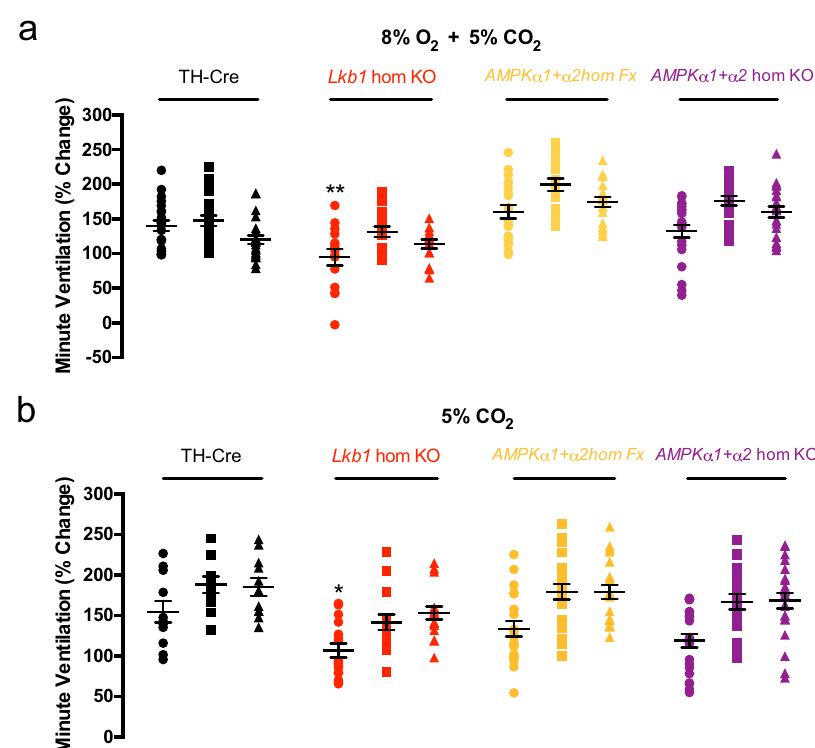
Fig. 8 Conditional deletion of Lkb1 in tyrosine hydroxylase expressing cells markedly slows the hypercapnic ventilatory response. Dot plots show mean ± SEM for increases in minute ventilation at ~30 s, 100 s and 300 s during exposures to a hypercapnic hypoxia (5% CO 2 + 8%O 2 ) and b hypercapnia (5% CO 2 ) for TH-Cre (black; 8% O 2 + 5% CO 2 , n = 17 independent experiments; 5% CO 2 , n = 20 independent experiments), conditional Lkb1 homozygous knockout mice ( Lkb1 hom KO, red; 8% O 2 + 5% CO 2 , n = 15 independent experiments; 5% CO 2 , n = 20 independent experiments), AMPK α 1 + α 2 homozygous fl oxed mice ( AMPK α 1 + α 2 hom Fx, beige; O experiments) and AMPK α 1 + α 2 homozygous knockout mice ( AMPK α 1 + α 2 hom KO, purple, O 2 + 5% CO 2 , n = 22 independent experiments; 5% CO 2 , n =